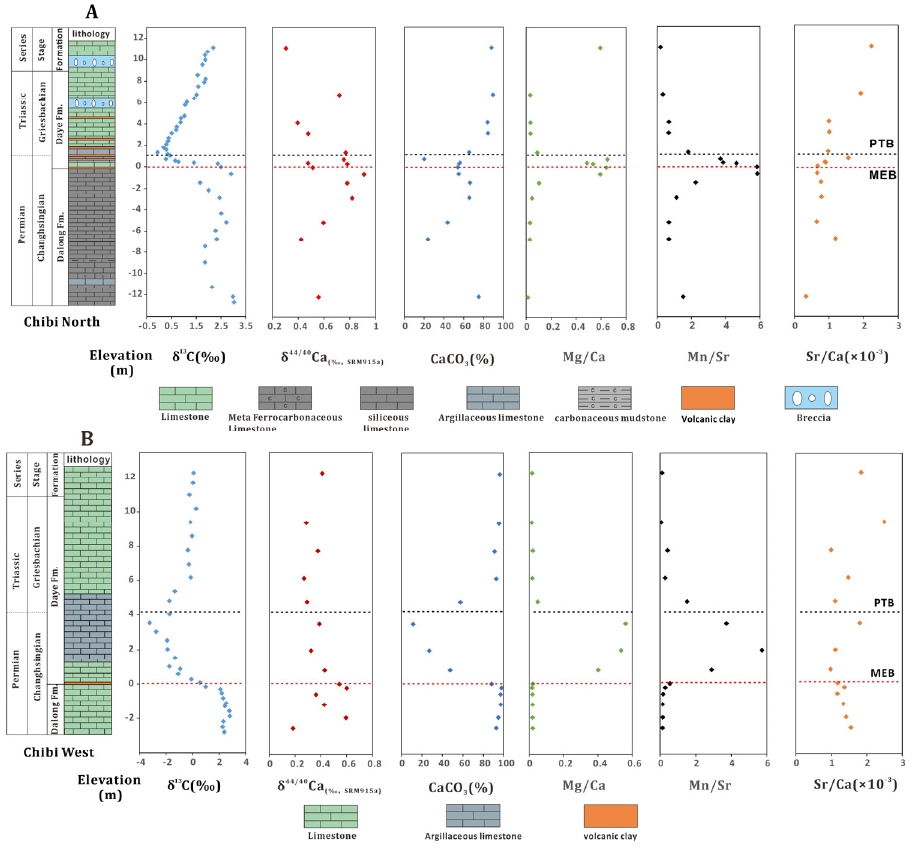
Figure 3. ( A ) Lithostratigraphy and chemostratigraphy of the Chibi North section, ( B